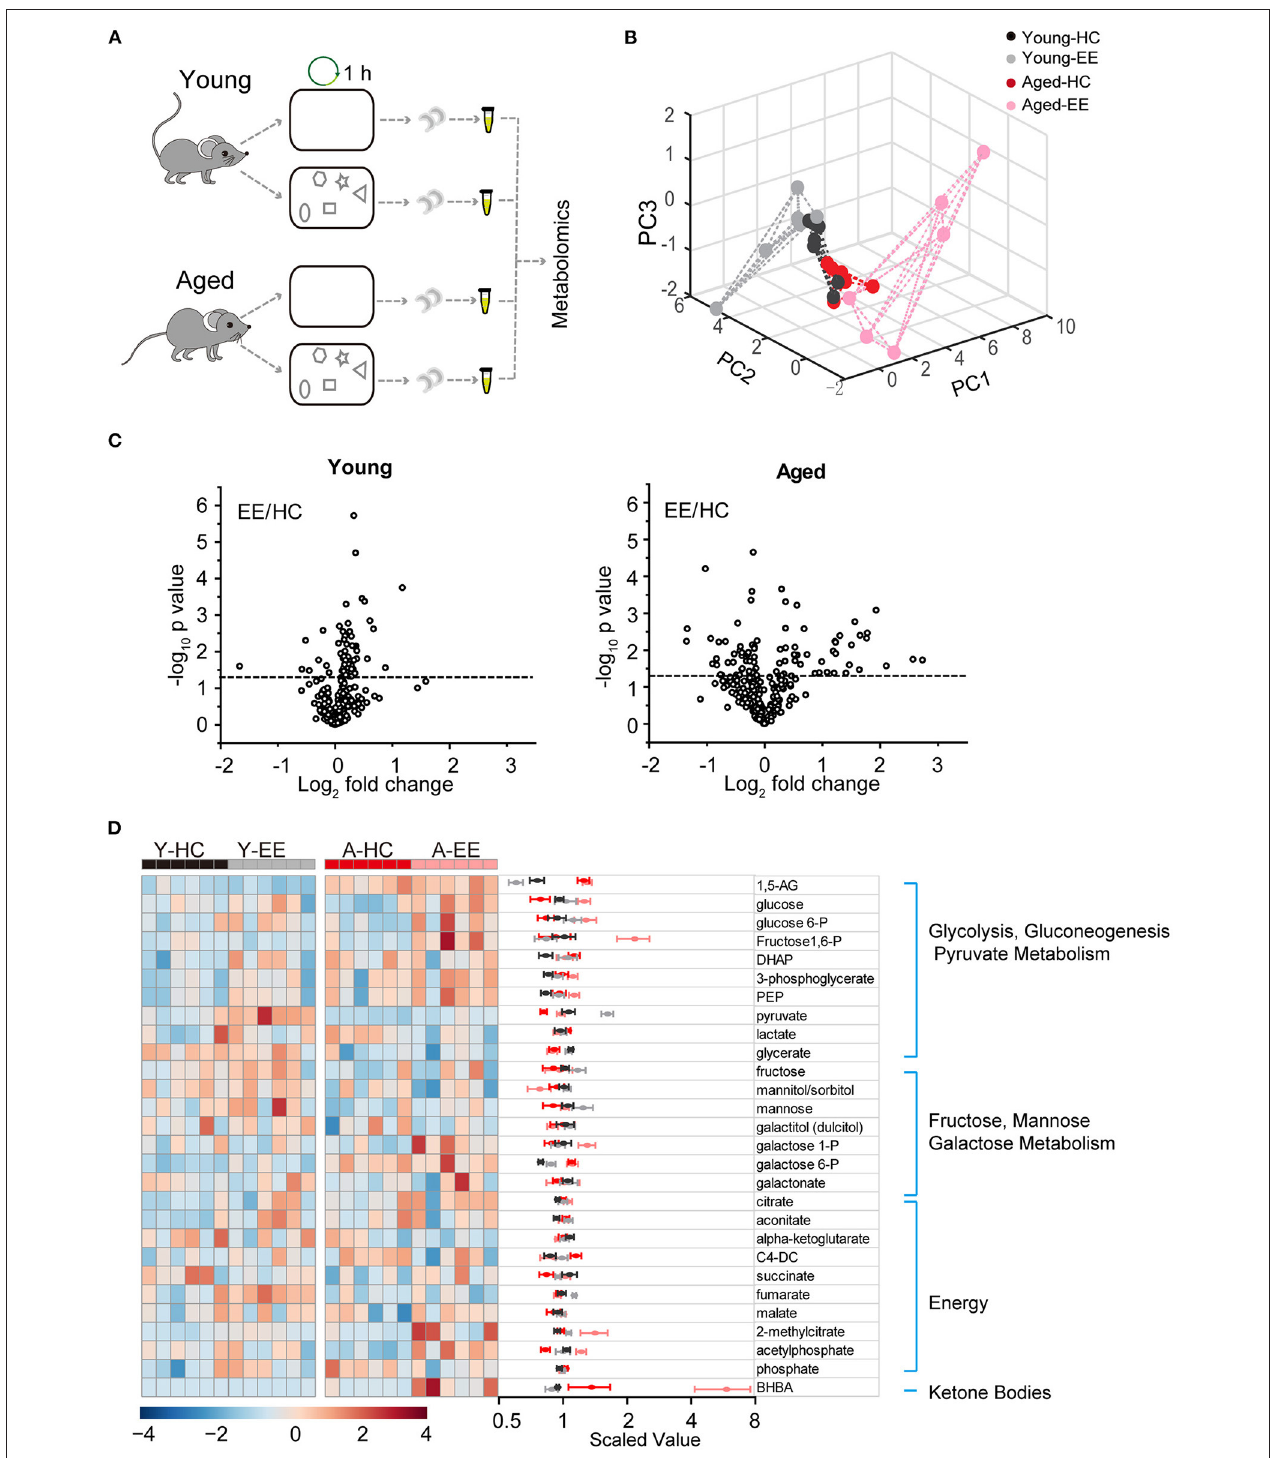
FIGURE 1 | Metabolic analysis of the hippocampus altered by content exploration in aged mice. (A) Experimental design schematic for the metabolic analysis of aged hippocampus. (B) PCA analysis of six repeats of young adult and aged group underlying home cage (HC) and enriched environment (EE) conditions. (C) Volcano plot of the fold-change and p -value for all 54 metabolites between HC and EE conditions. The horizontal dashed line represents the significance cutoff specified in the analysis ( p < 0.05). HC, n = 6; EE, n = 6; unpaired t -test. (D) Hierarchical clustering heatmap and averaged value of metabolites between HC and EE conditions.